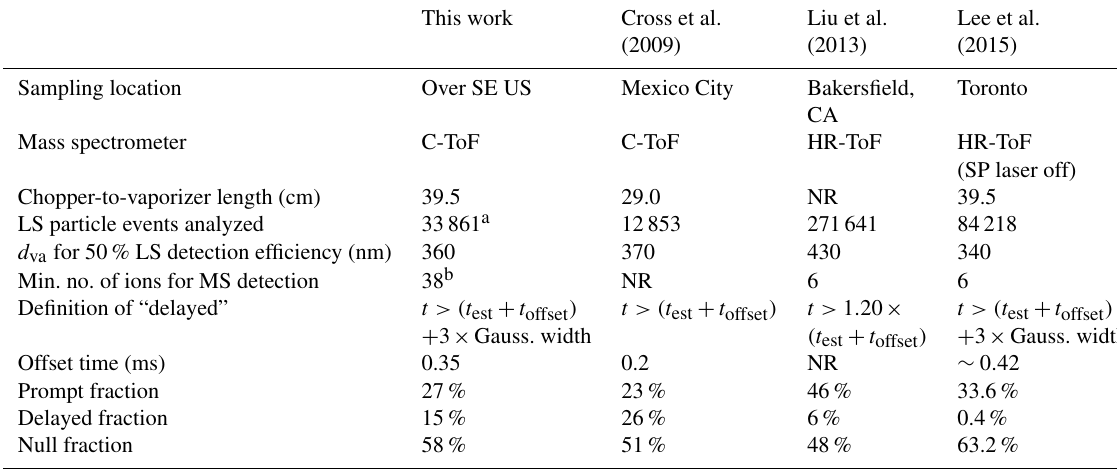
This work Cross et